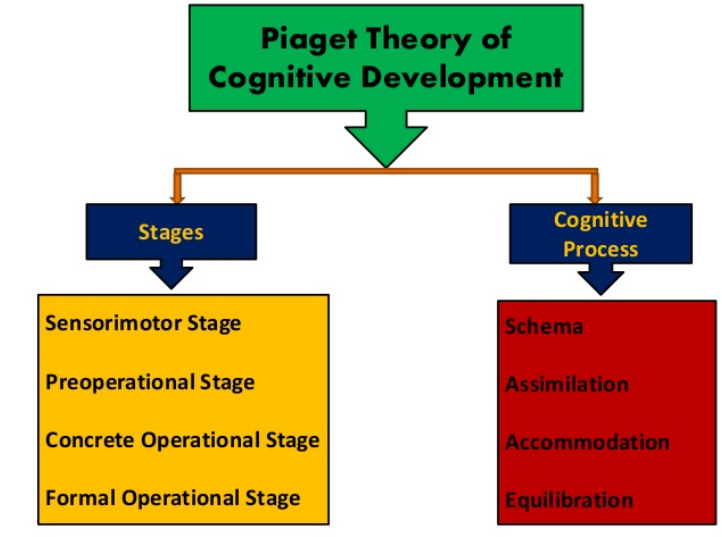
Fig. 1. Piaget Theory of Cognitive